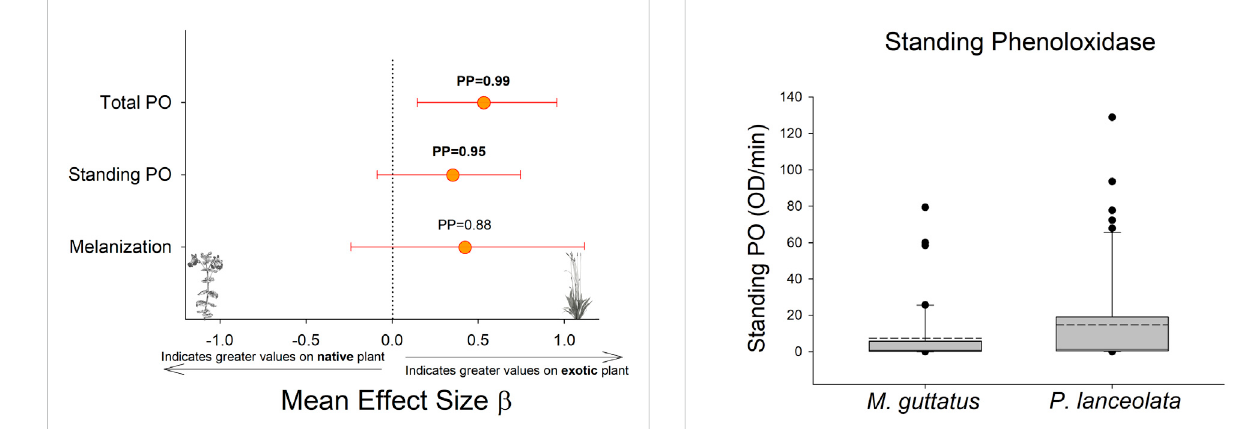
FIGURE 2 Comparison of each immune response measurement on the native host plant ( M. guttaus ) vs the exotic host plant ( Plantago lanceolata ).The meaneffect sizeonthe x -axisshows thedifferencein means between the two host plants for each immune response measurement.Thenativehostplantisusedasthereferencecondition in each comparison, thus positive mean effect size values indicate largereffectswhenrearedontheexotichostplant,andnegativemean effectsizevaluesindicatelargereffectswhenrearedonthenativehost plant. All response values have been transformed to z-scores. Bayesian posteriorprobabilities (PP) and 95% highest posterior density intervals (HPDI) are shown.